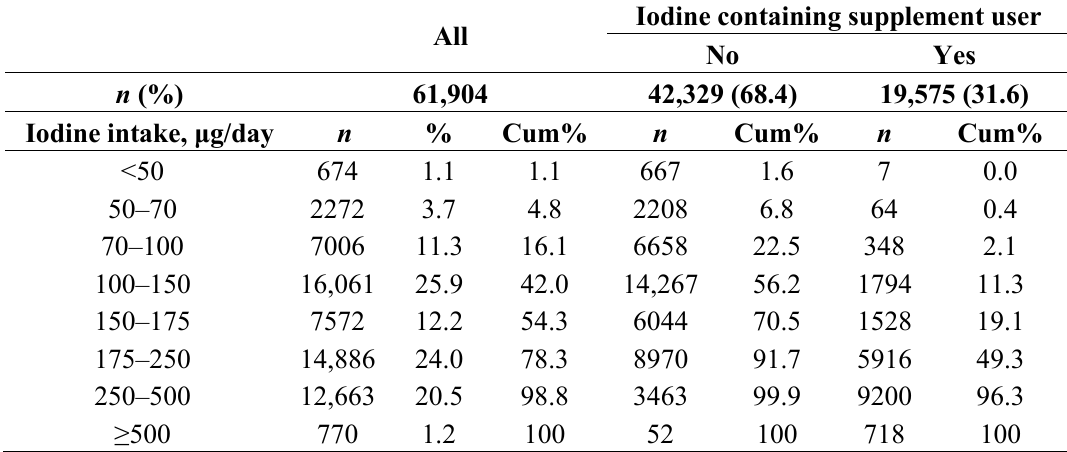
Table 1. Iodine intake in 61,904 pregnant Norwegian women in the Norwegian Mother and Child Cohort Study, 2002–2008.